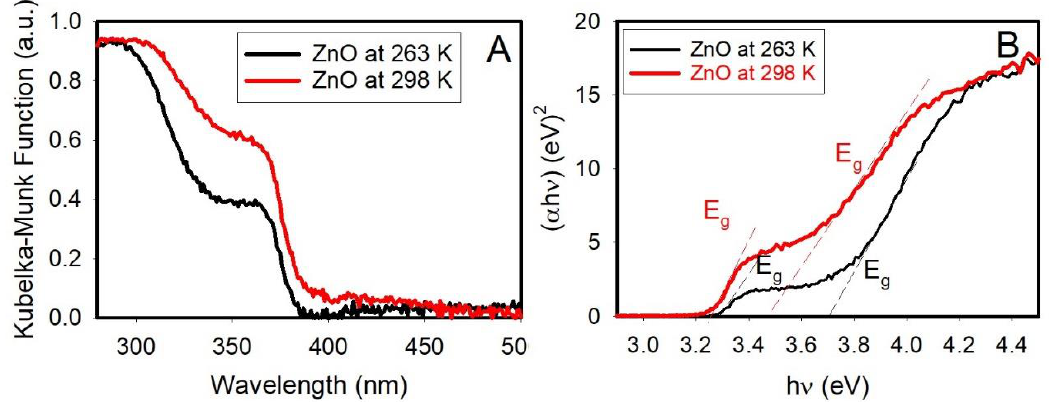
Figure 2. Diffusive reflectance spectra (DRS) ( A ); and the Tauc plots ( B ) of SiO 2 -coated ZnO slides at 263 and 298 K (ambient temperatures) suggest direct optical bandgaps.